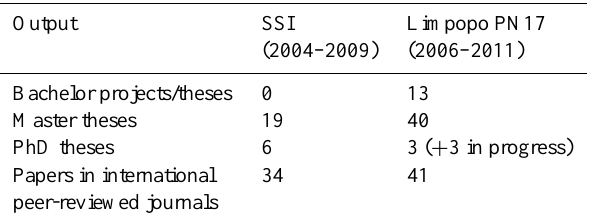
Table 2. Citations of articles published in the WaterNet/WARFSA Special issues of Physics and Chemistry of the Earth, 2002–2011. Based on Scopus (www.scopus.com), consulted January 2012.